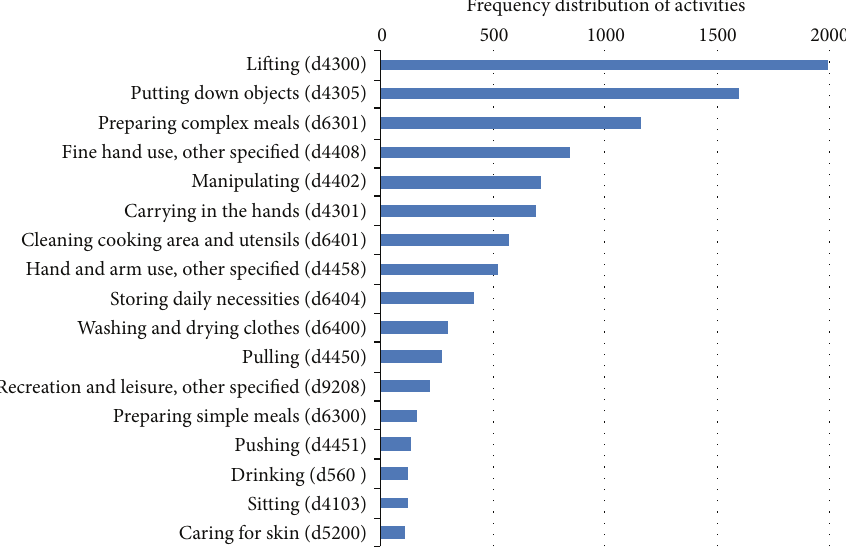
Figure 4: Frequency of distribution of activities [11].